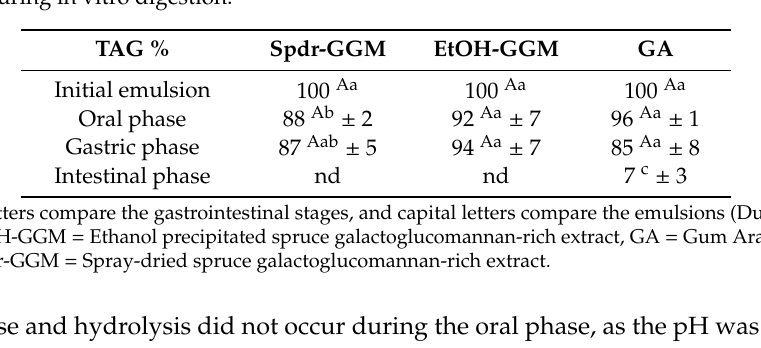
Table 1. Proportion of triacylglycerols (TAG %) in Spdr-GGM-, EtOH-GGM-, and GA-stabilized emulsions during in vitro